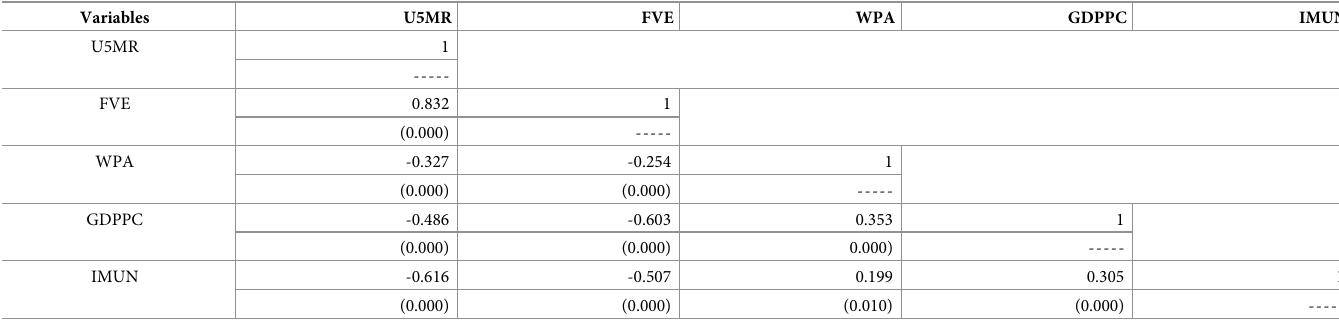
Table 3. Correlation matrix.